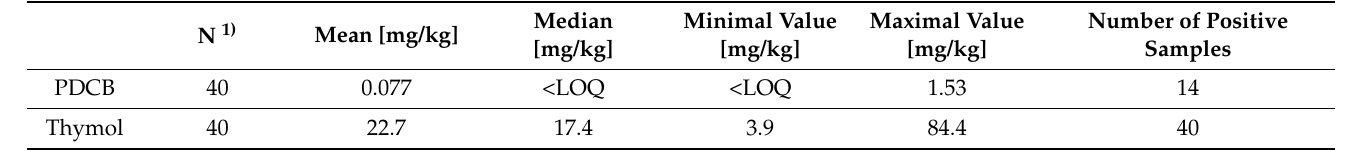
Table 5. Mean, median, minimal, and maximal values of PDCB and thymol in commercial Swiss beeswax foundation samples (N = 40) produced in 2019 and